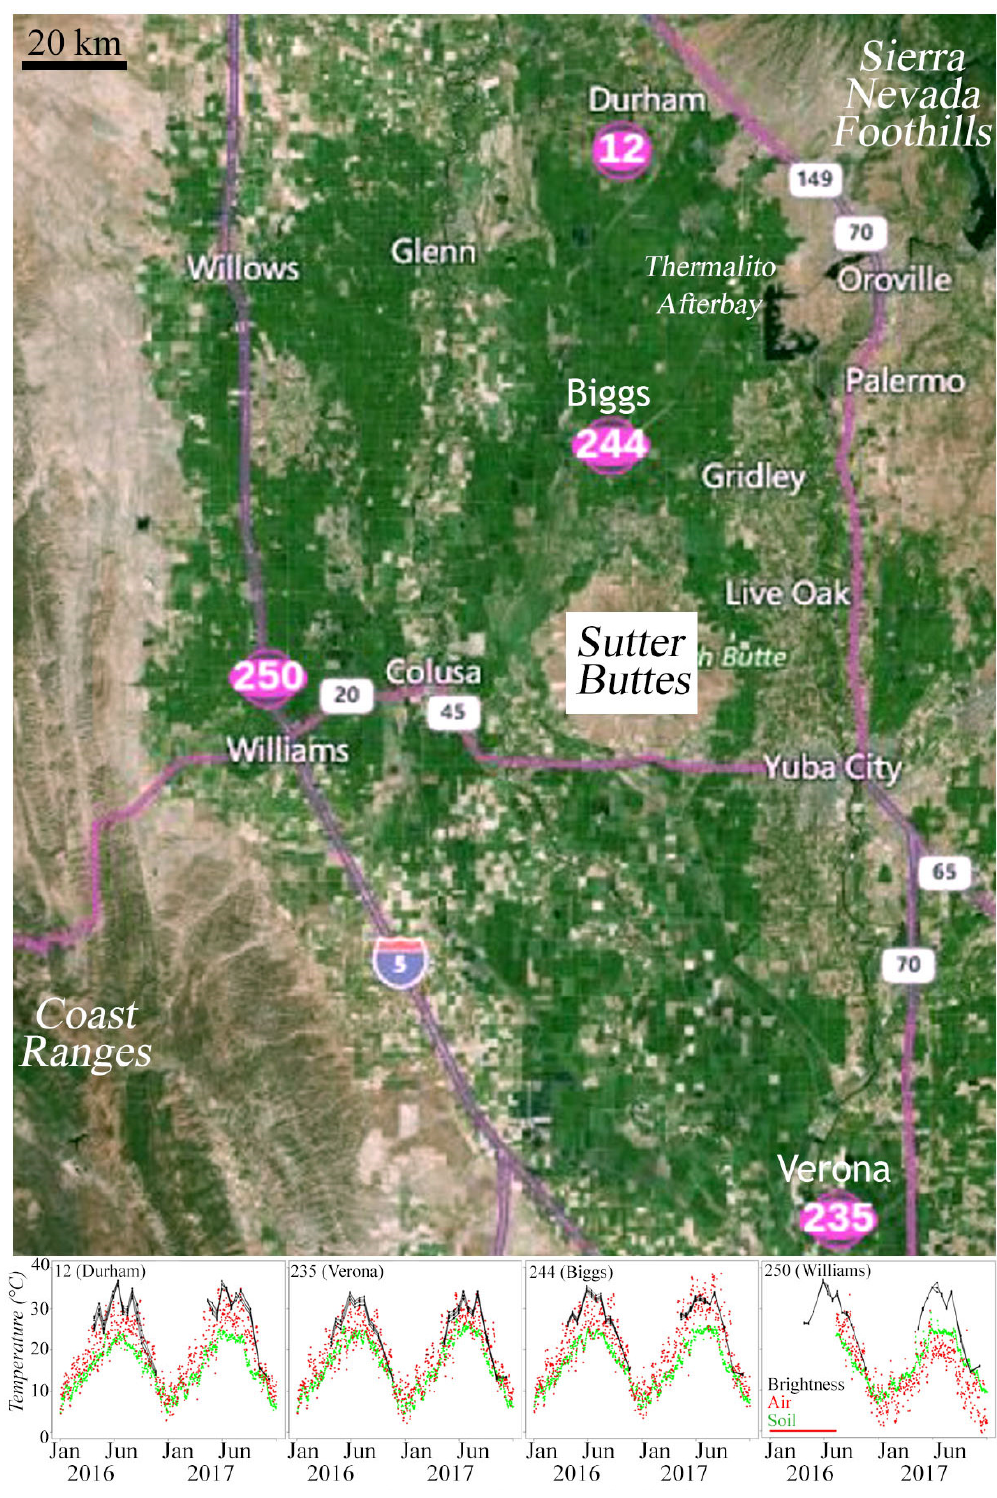
Figure 9. Four met stations are maintained in the study area by the California Irrigation Management Information System (CIMIS). Two more stations exist just to the south of the area. Air temperatures (red) are generally higher and more variable than soil (green). Durham, Verona, & Biggs records are generally similar, with Landsat-observed brightness temperatures (black) at the warm bound of the envelope of air temperatures. The Williams station (installed mid 2016) has substantially lower air, but similar soil and brightness temperatures, to the other stations.